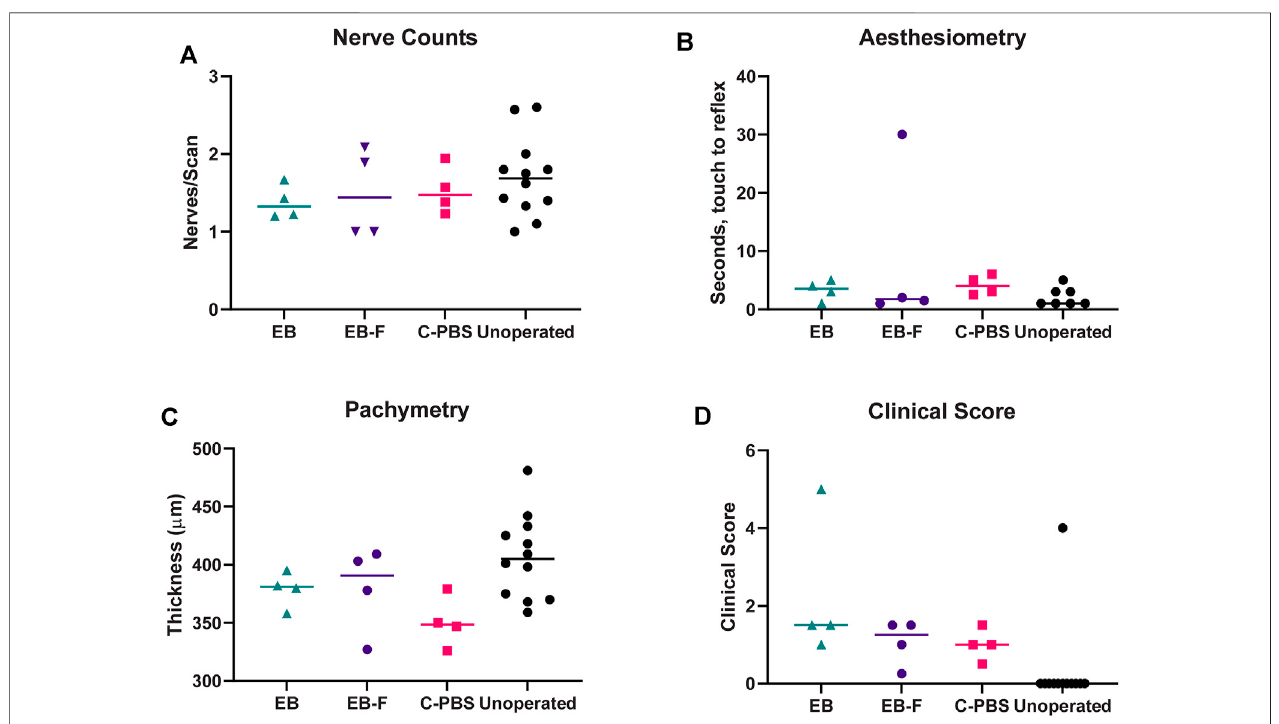
FIGURE 3 | Innervation, thickness and microscopy ofthe regenerated cornea. (A) Number of nerve fi bers per central IVCM corneal scan in RHCIII-MPC implanted corneas at 6 months post-implantation. (B) Results of Cochet-Bonnet corneal aesthesiometry at 6 months after surgery. (C) Corneal thickness at 6 months post-